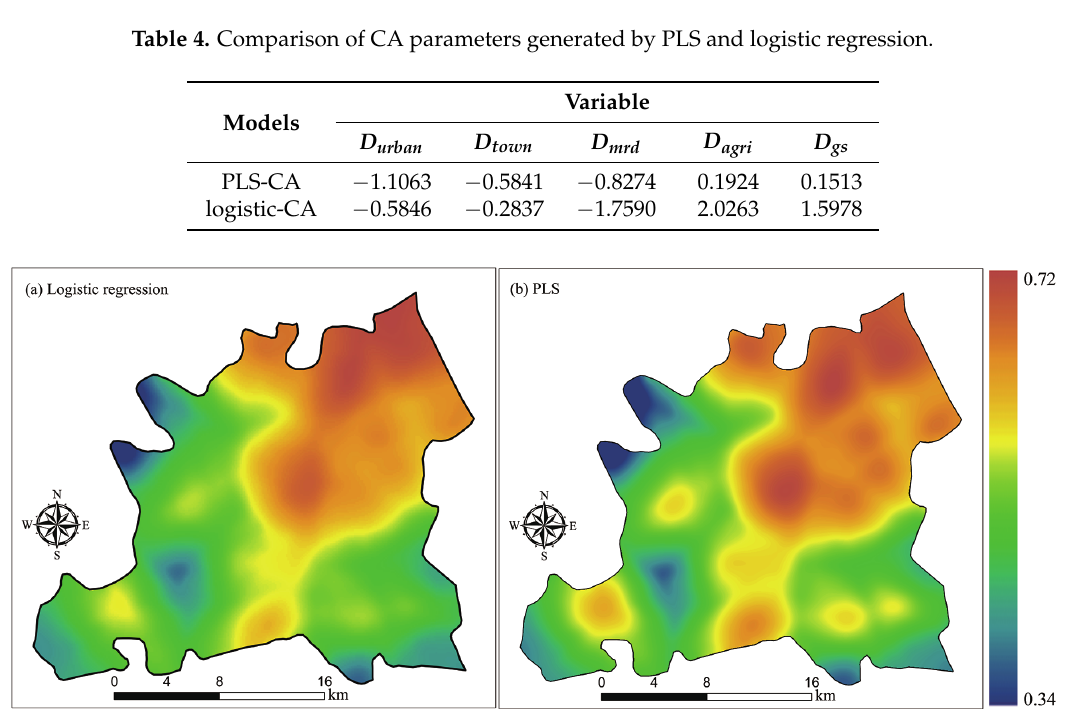
Figure 4. Land conversion potential based on spatial variables. ( a ) Logistic regression and ( b ) PLS.